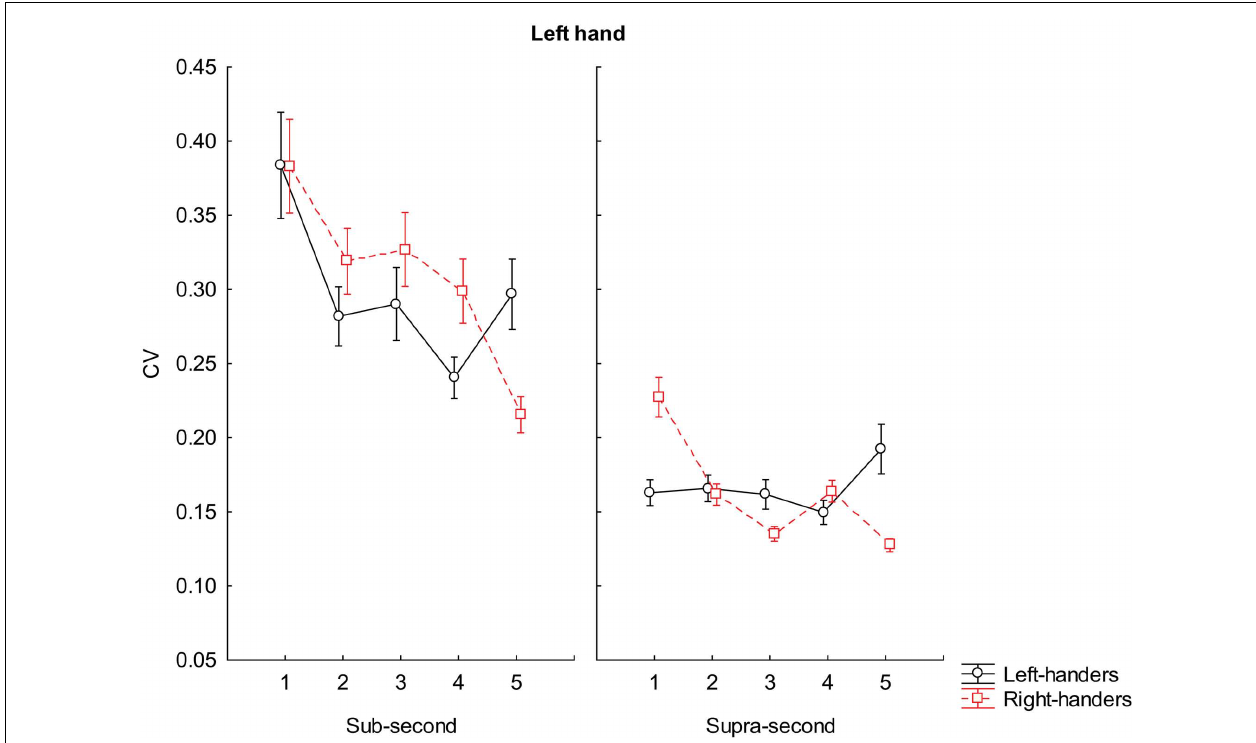
FIGURE 3 | Coefficient of variation scores during reproduction of sub-second and supra-second intervals with left hand. The vertical bars indicate SE mean.